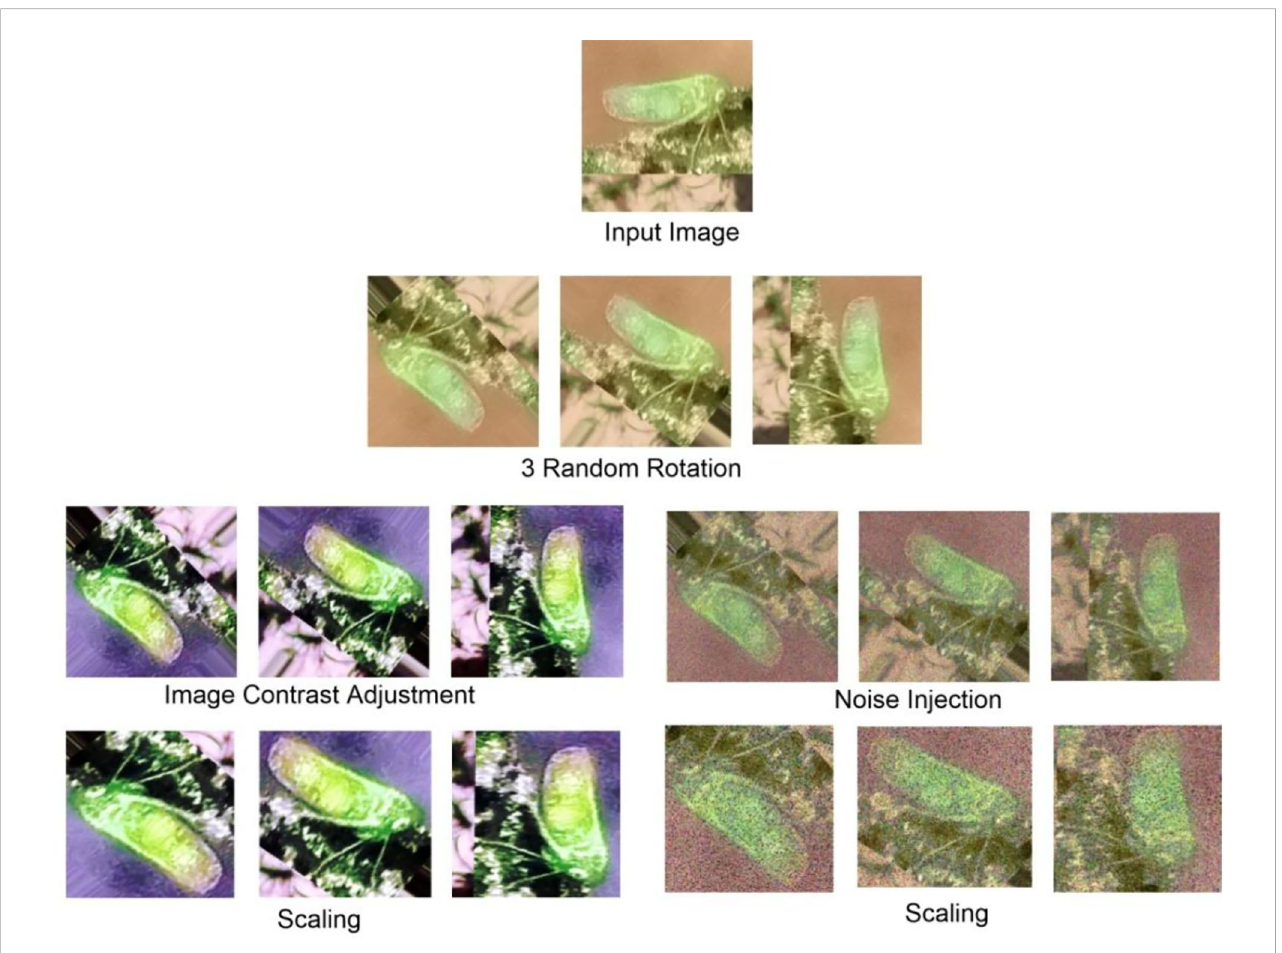
FIGURE 2 Augmented data of leafhopper